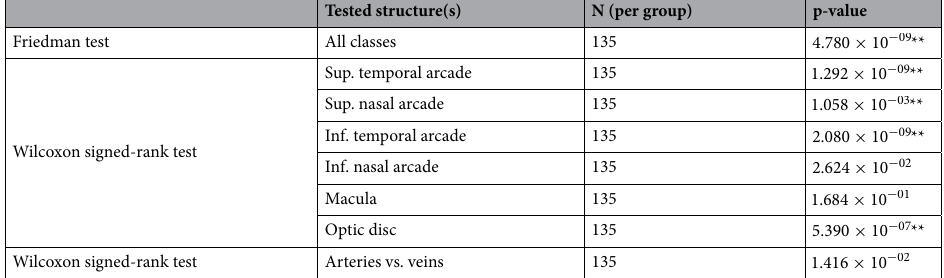
Table 3. Results of three statistical tests to investigate the role of specific anatomical structures in the predictions. * and ** mark significant and highly significant p-values ( α = 0.05 and α = 0.01 ). Bonferroni correction is applied to the Wilcoxon signed-rank tests ( α ind = 0.00714 and α ind = 0.00142 ). The tests compare patches containing anatomical structures with ones that show